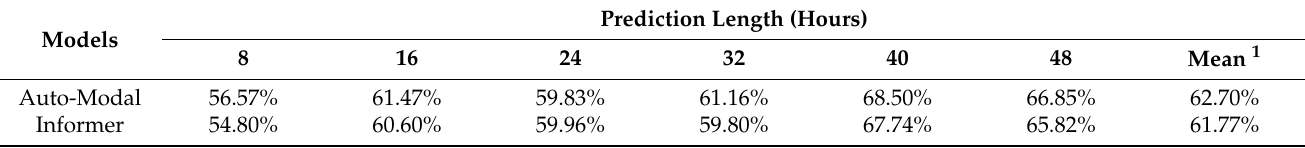
Table 5. RFP of the informer and auto-modal